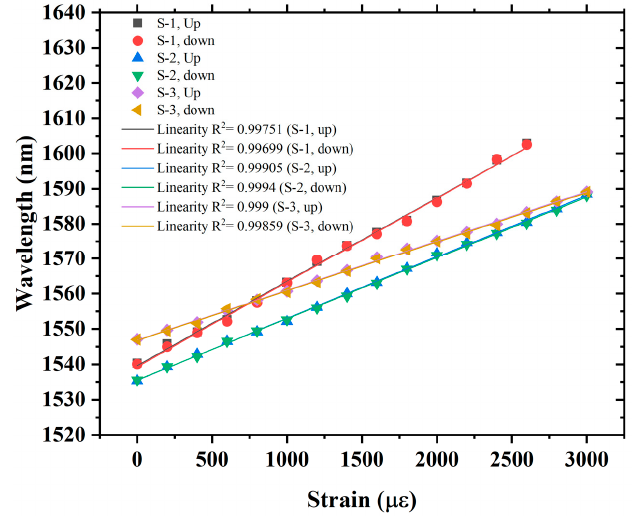
Figure 12. Repeatability test of the proposed sensor. Table 2. Comparison of the proposed sensor with earlier reported